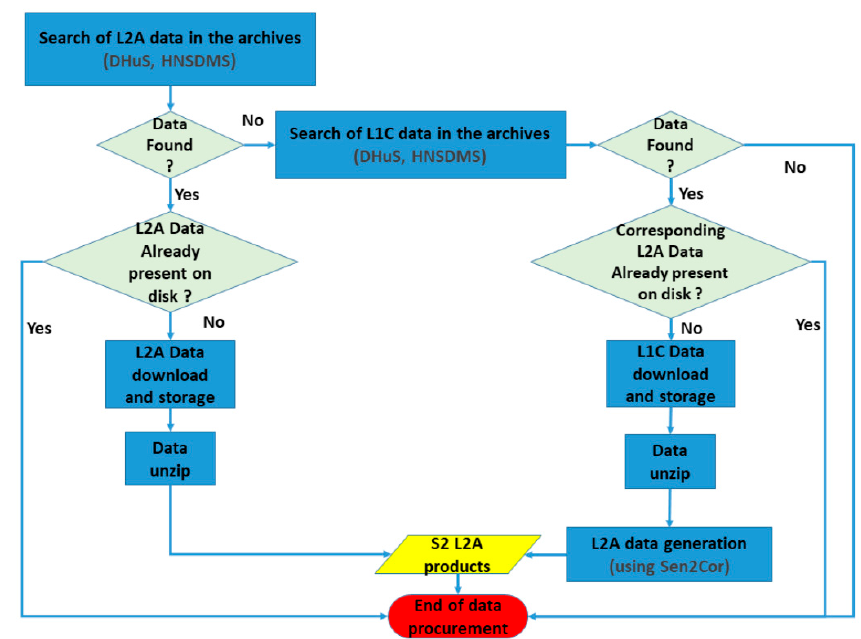
Figure 3. Block diagram of the script for S2 data procurement implemented in AUTOBAM.